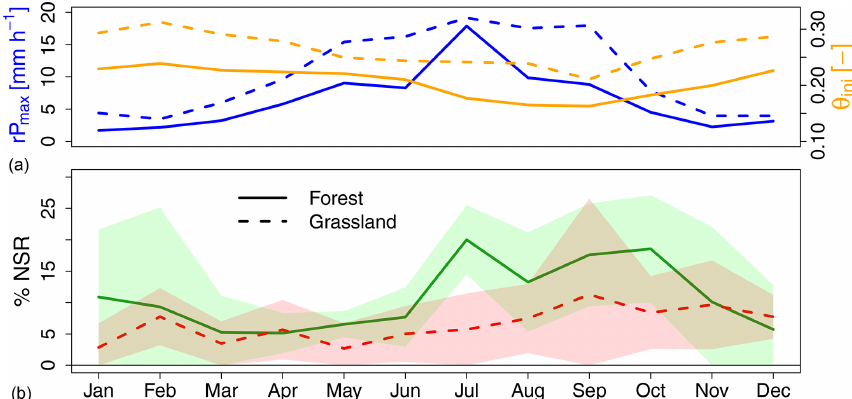
Figure 7. Monthly mean rP max and θ ini (a) and fraction of NSR events for the two land covers (b) . The solid lines represent the forest and the dotted lines the grassland response. The shaded areas in the lower diagram show the standard deviation between the single years for each month. For the number of events observed in the individual month over the total time period and for individual years, see the Supplement (Table S5).